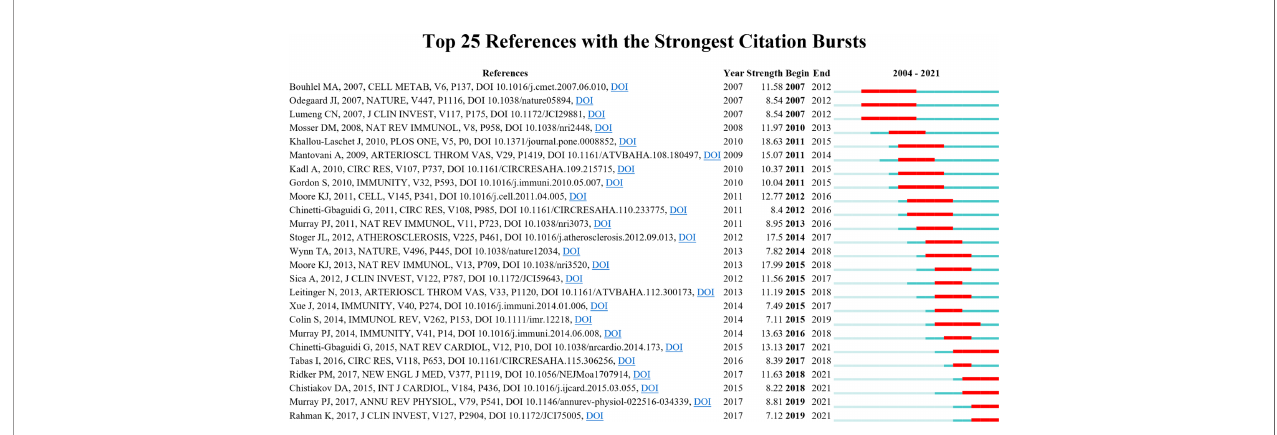
FIGURE 9 | Top 25 references with the citation bursts (sorted by the beginning year of the burst). The blue bars mean the reference had been published; the red bars mean citation